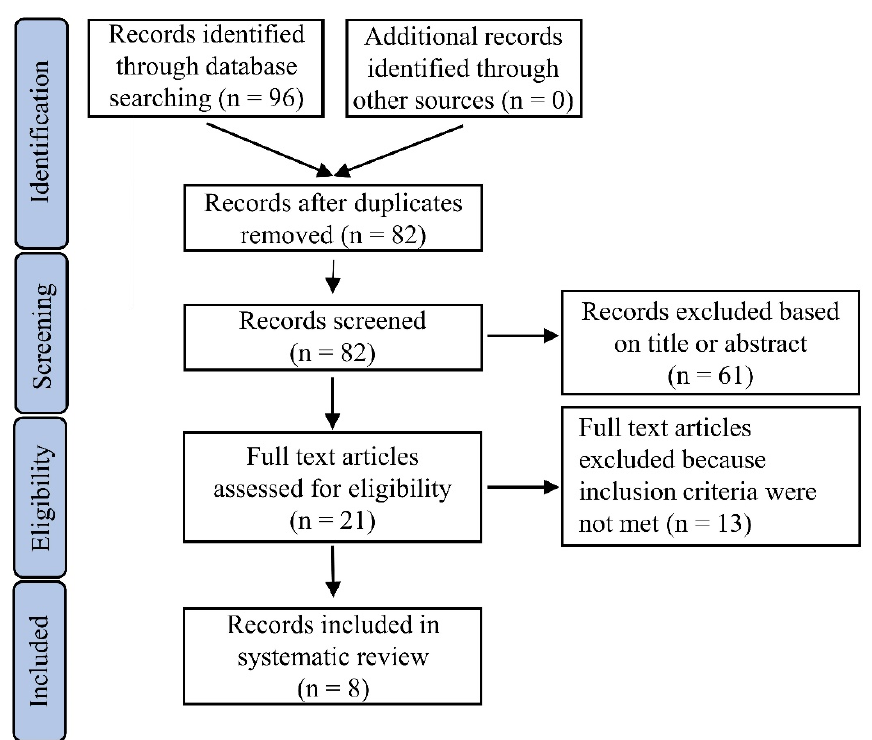
Figure 1. Flow diagram of selected studies for inclusion in the systematic review.